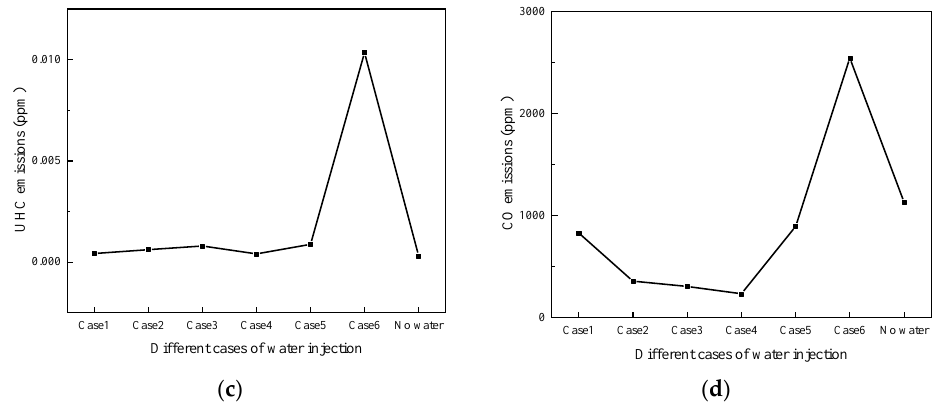
Figure 20. ( a ) Soot, ( b ) NOX, ( c ) UHC and ( d ) CO emissions in different water injector positions (CR = 10.3, ignition time = − 14 degCA).